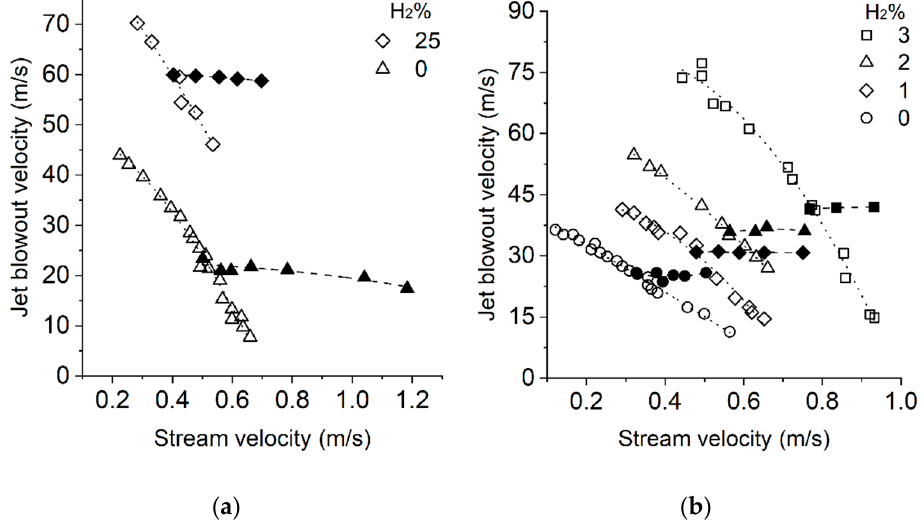
Figure 21. Flame blowout during combustion of methane and hydrogen–methane with different volume fractions of hydrogen [48,49]: ( a ) for methane–hydrogen fuel jet and air stream; ( b ) for methane fuel jet and air–hydrogen stream.